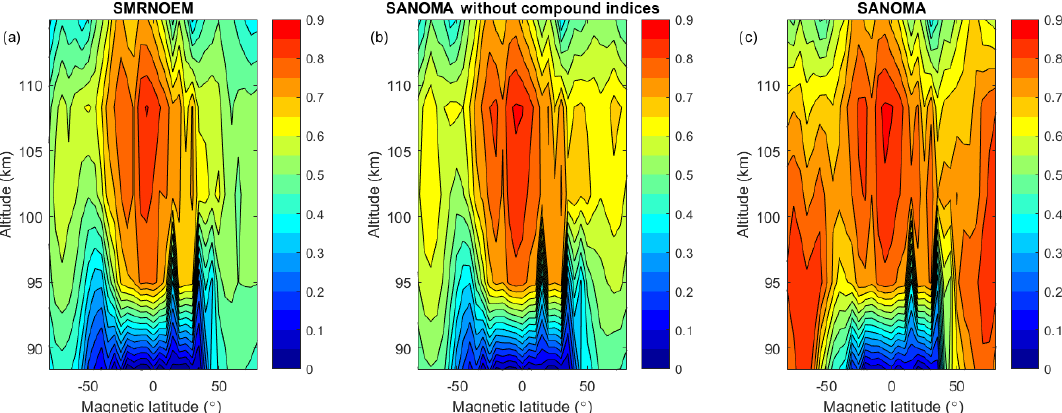
Figure 11. Adjusted R 2 between SMR and an empirical model from Odin SMR NO using (a) Eq. (1), (b) Eq. (4) without com 1 or com 2 , and (c) Eq. (4).